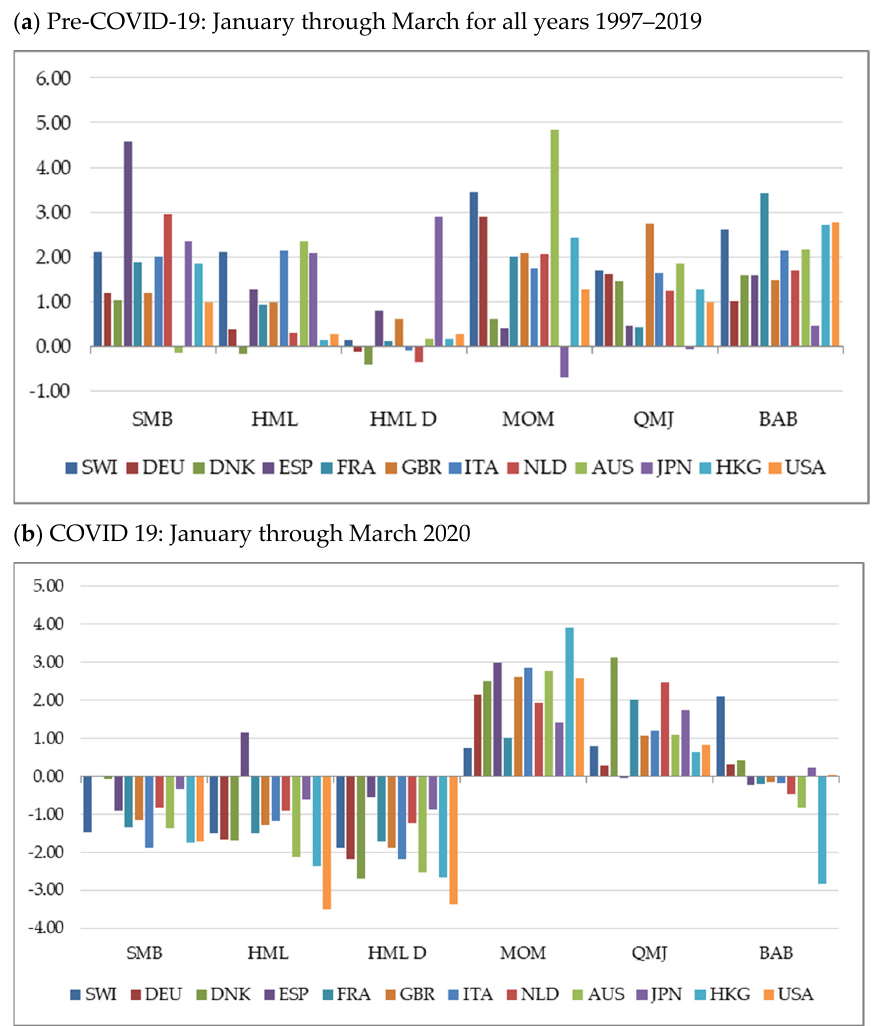
Figure 2. t -Statistics for the CAPM Alphas for the Risk Factors: By Country. This figure displays the t -statistics for testing the significance of the intercept from a regression of each alternative risk factor on the excess market returns for representative stock markets around the world. See notes in Table 1 for the definition of the factors and the countries. ( a ) shows the results when using monthly data for the first quarter of each of the years between 1997 and 2019, and ( b ) shows the results when using daily data for the subperiod affected by the first impact of the COVID-19 pandemic from January